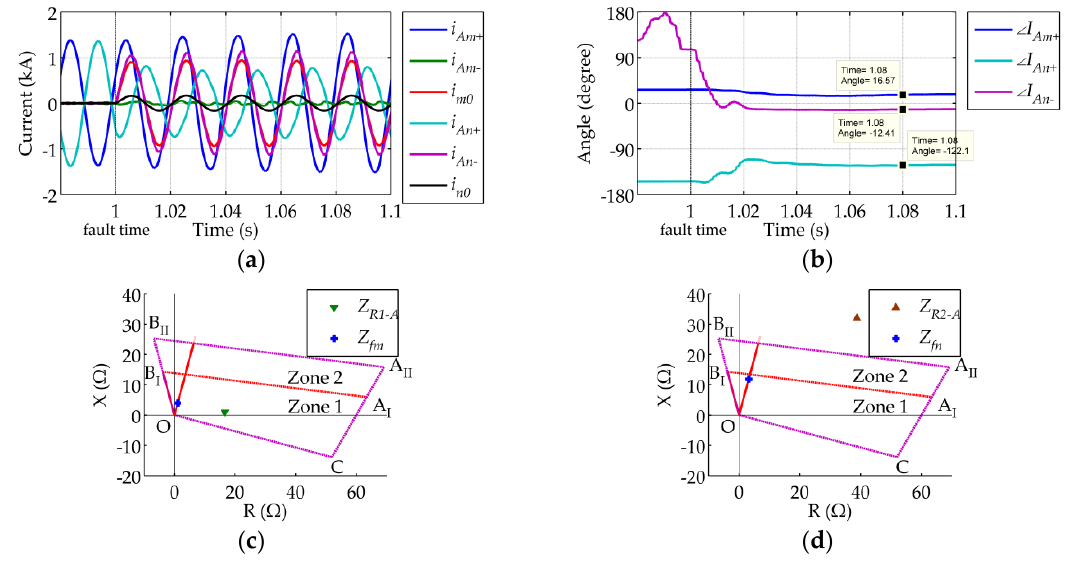
Figure 16. Sequence components of the fault currents and measured impedances in Case 1: ( a ) The sequence components of the currents flowing through R1 and R2; ( b ) Phase angles of the sequence components; ( c ) Measured impedance of the AG element in R1; ( d ) Measured impedance of the AG element in R2.